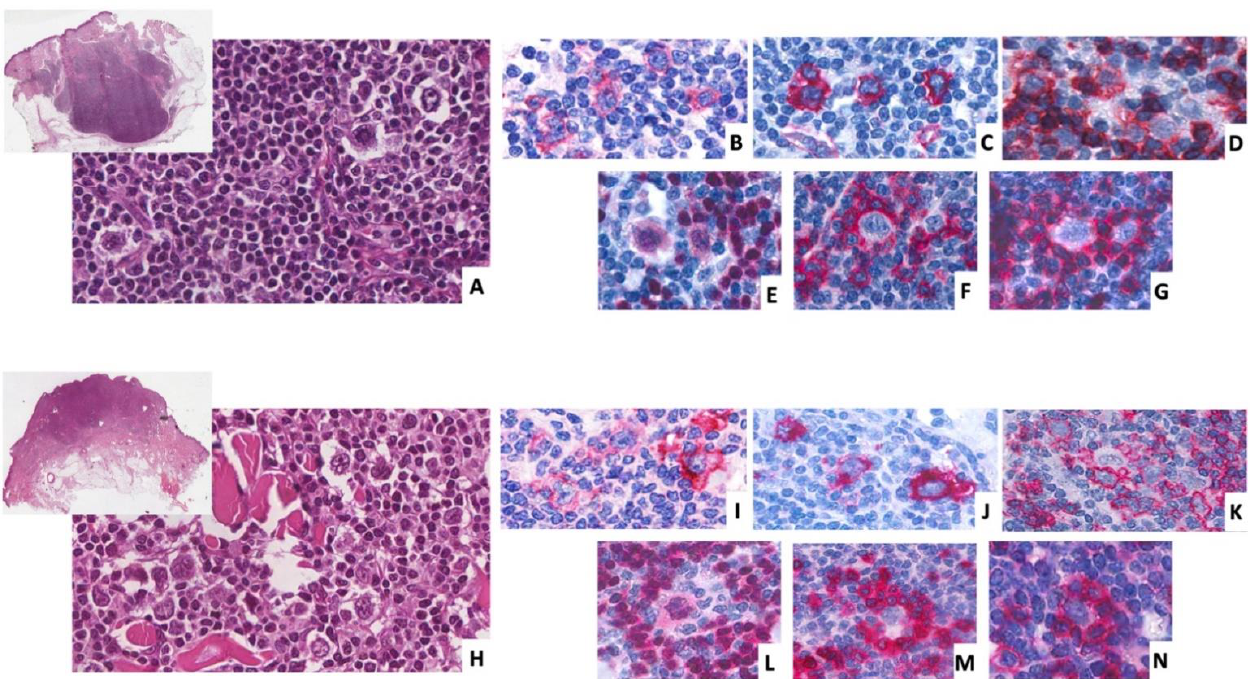
Figure 3. Histology of cutaneous lesion of patient 2 ( A – G ) and of patient 3 ( H – N ). Patient 2 showed a diffuse lymphocytic infiltrate involving the dermis and the adipose subcutaneous tissue, whereas patient 3 showed a nodular infiltrate confined to the dermis. In both cases, the infiltrate was mainly composed of small lymphocytes with sparse plasma cells and scattered large cells with H/RS-like morphology (( A , H ) hematoxylin and eosin ( H , E ) 400 × , upper insert 20 × ). The large atypical cells were strongly positive for CD30 (( B , I ), 400 × ) and CD15 (( C , J ), 400 × ), and showed a heterogeneous expression of CD20 (( D , K ), 400 × ) and PAX5 (( E , L ) 400 × ). Small reactive CD3+ (( F , M ), 400 × ) and PD1+ (( G , N) , 400 × ) T cells were rosetting around the H/RS-like cells. PCR clonality testing detected a prominent IGH clonal peak that corresponded to a productive VH3-15_02-JH6_02 rearrangement by NGS analysis accounting for 5.81% of the total reads (total reads count 9977) (Figure 4A–C). A final diagnosis of PCMZL with H/RS CD30+ large cells was made. Staging CT and PET scans were negative.